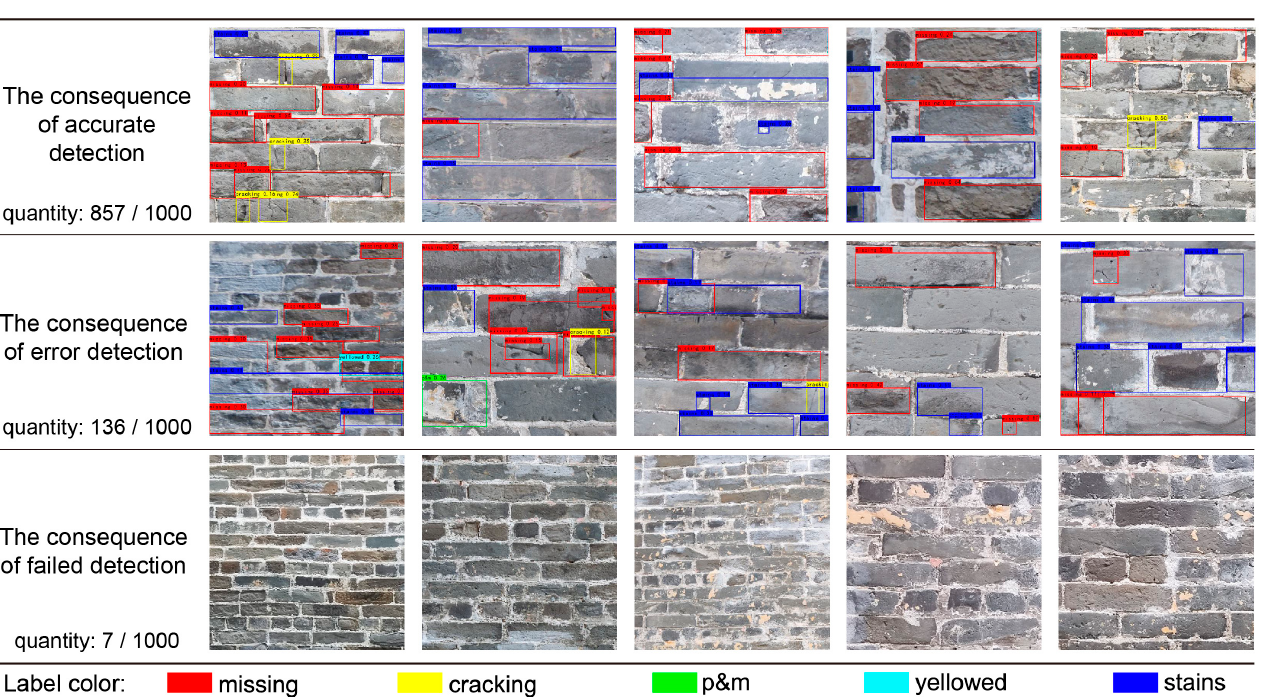
Figure 13. Manual Validation of Models. (Image Source: drawn by the author).